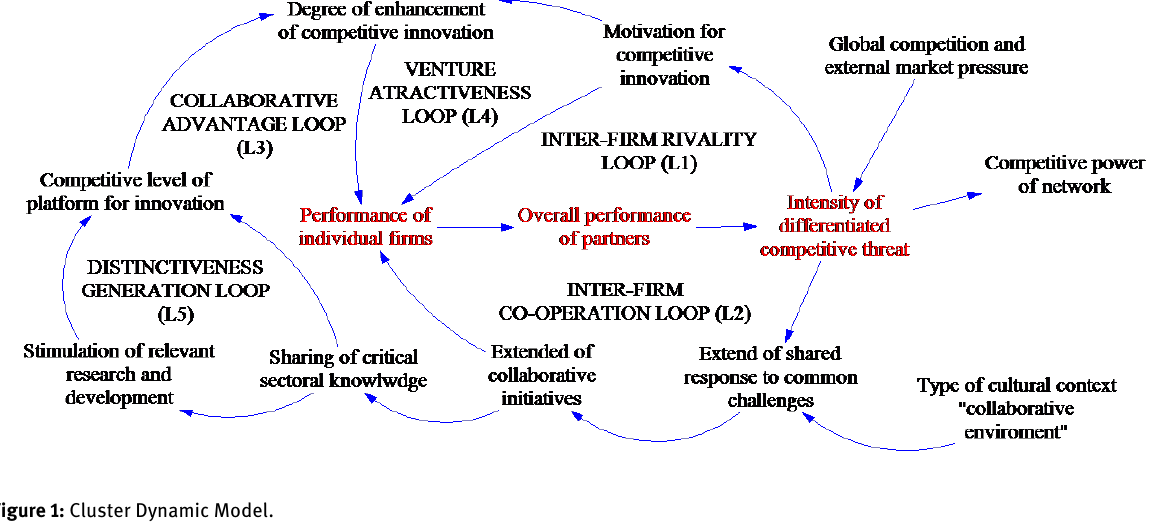
Figure 1: Cluster Dynamic